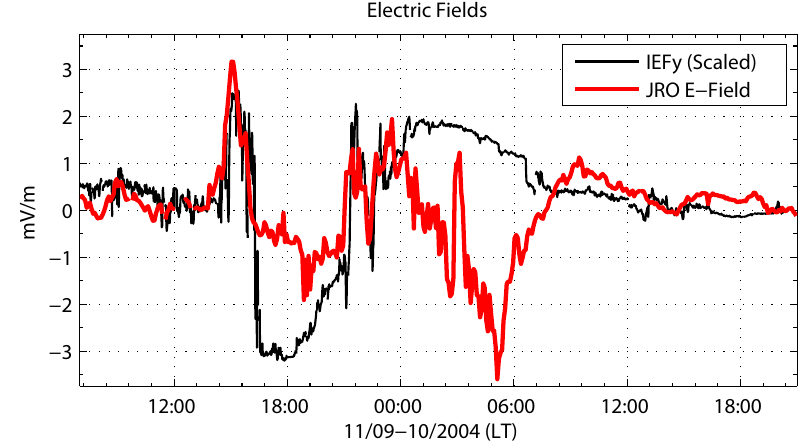
Fig. 1. Electric field measured at Jicamarca with the IEF y divided by ten (figure courtesy of Ronald Ilma).